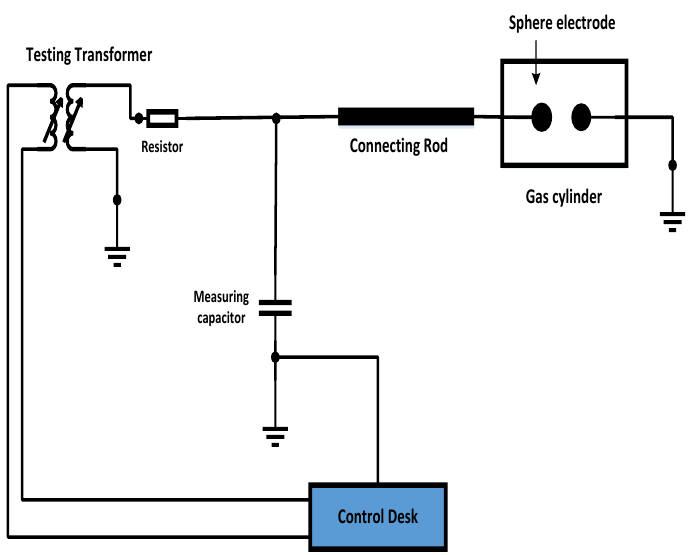
Figure 1. Schematic to examine R152a/CO 2 breakdown voltage by sphere–sphere electrodes.